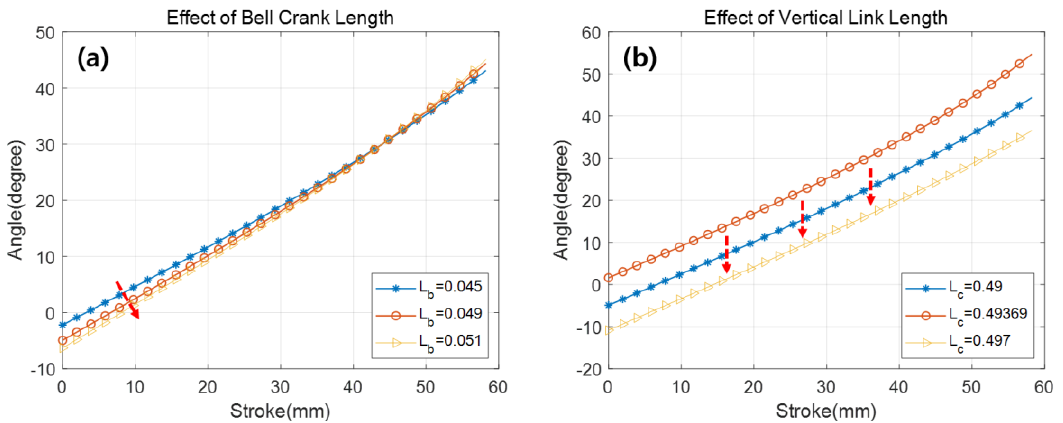
Figure 6. Effect of link lengths on relations between vane angle and actuator stroke. ( a ) Effect of bell crank length ( 𝐿 𝑏 ); ( b ) Effect of vertical link length ( 𝐿 𝑐 ).